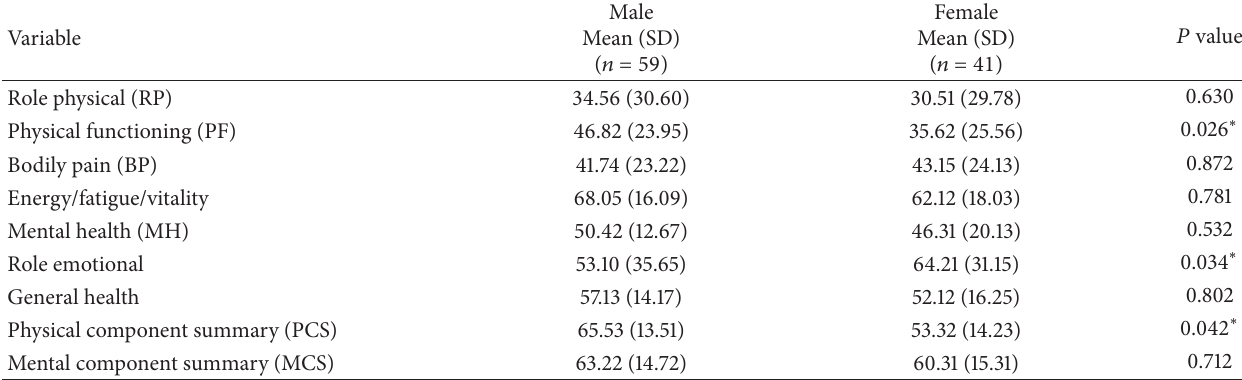
Table 3: Measurement of central tendency and distribution of quality of life among sample.